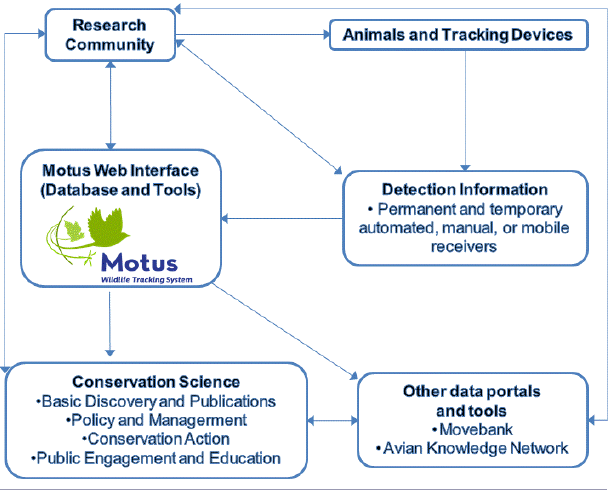
Fig. 2 . Conceptual diagram of the flow of information and data through the Motus network. Researchers tag animals,